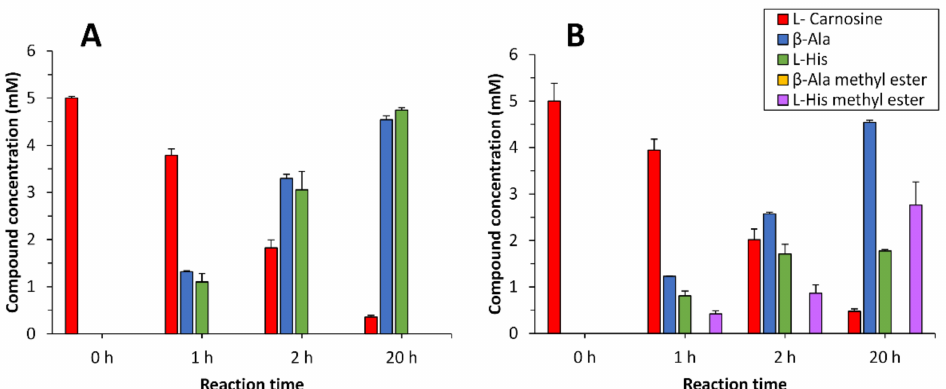
Figure 6. Concentrations of the substrates, intermediates and final products obtained for the con- version of L-carnosine by the EH 1AB1C PluriZyme in the absence ( A ) or presence ( B ) of methanol. Reaction conditions in A: [cells expressing EH 1AB1C ]: 5 µ L of resuspended cells at OD 600 nm of 15.0; [L-carnosine]: 5 mM; buffer: 92.5 µ L 40 mM HEPES, pH 7.0; reaction final volume: 100 µ L. Reaction conditions in A: [cells expressing EH 1AB1C ]: 5 µ L of resuspended cells at OD 600 nm of 15.0; [L-carnosine]: 5 mM; solvent: 92.5 µ L methanol; reaction final volume: 100 µ L (92.5% methanol). Note, that the amount of the β -Ala methyl ester was below the detection limit under our experimental conditions, and this is why yellow bars are not visible in the figure. The figure was created using SigmaPlot 14.0